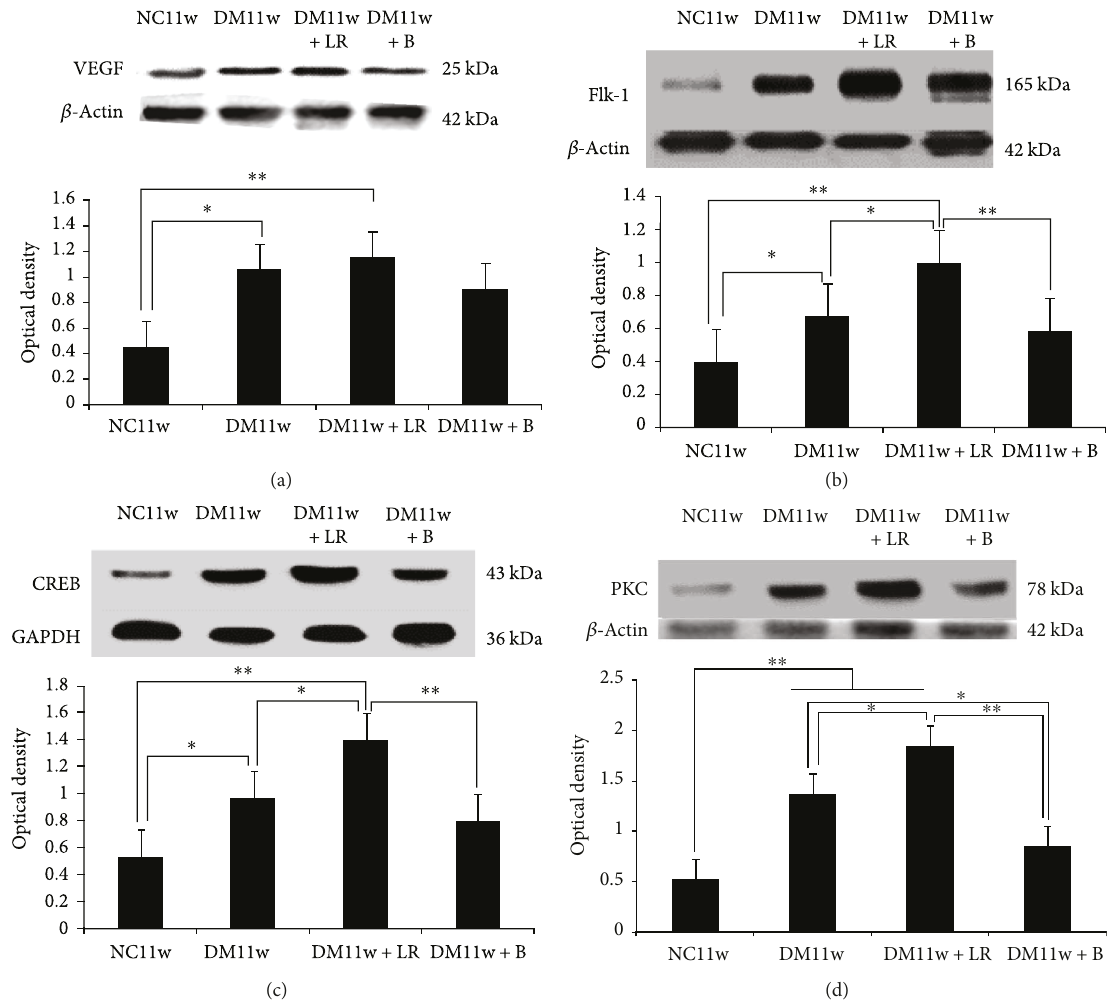
Figure 12: (a) Western blot analysis showed the expression of VEFG, Flk-1, CREB, and PKC in the NC11w, DM11w, DM11w+LR, and DM11w+B groups, including the immunoreactive bands of VEGF (21 kDa), iNOS (130kDa), eNOS (140kDa), nNOS (155kDa), and β - actin (42 kDa). Bar graph showed the semiquantitative data of Western blot analysis of VEGF (a), Flk-1 (b), CREB (c), and PKC (d). (a) VEGF showed an evident increase in the DM11w and DM11w+ LR groups compared with the NC11w group. (b – d) Flk-1, CREB, and PKC showed signi fi cant increase in the DM11w and DM11w+LR groups compared with the NC11w group, which was attenuated in the DM11w+B group. ∗ p < 0 05 and ∗∗ p < 0 01